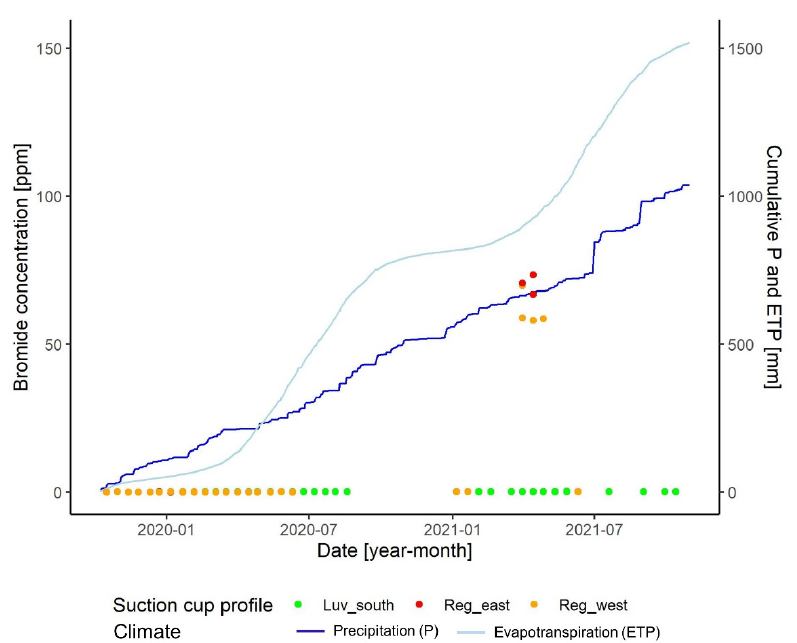
Figure 3. Cumulative precipitation P ( dark blue line ) [mm], cumulative potential evapotranspiration ET P ( light blue line ) [mm], and bromide concentrations (dots) at the suction cup profiles (40 and 160 cm depth) during the period from 8 October 2019 to 31 October 2021 (see Figure 2) of the Regosol and Luvisol. A total of 1038 mm of precipitation was recorded within this period.